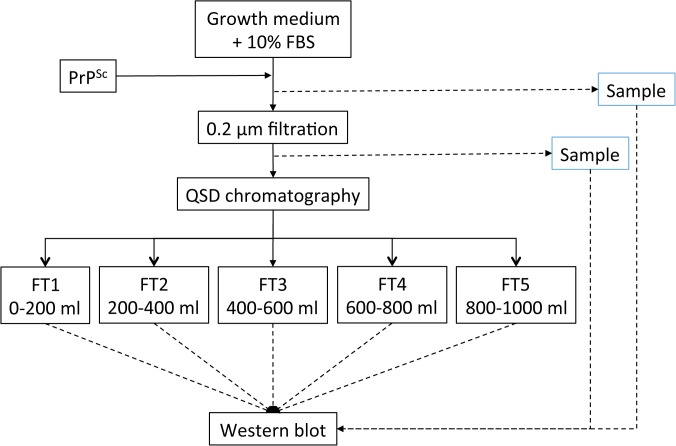
Experimental design for assessing the removal of PrPSc from growth media by using QSD filtration.Details of the procedure are described in the Material and Methods section.